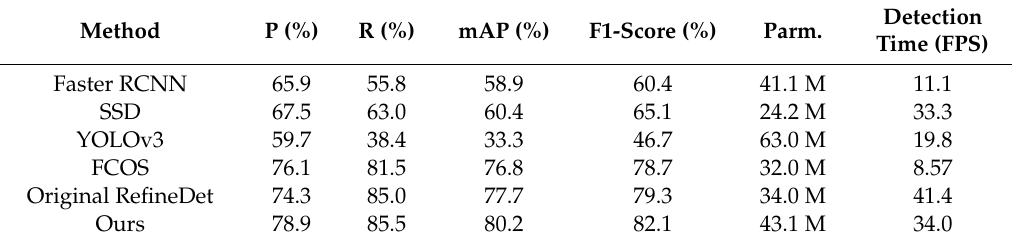
Figure 10. Experiment display of the proposed method on the TILDA dataset. ( a ) The loss of the proposed method on the TILDA dataset in the training stage; ( b ) The P-R curve of the proposed method on the TILDA testing set. Table 2. Performance comparison of different object detection approaches on TILDA dataset